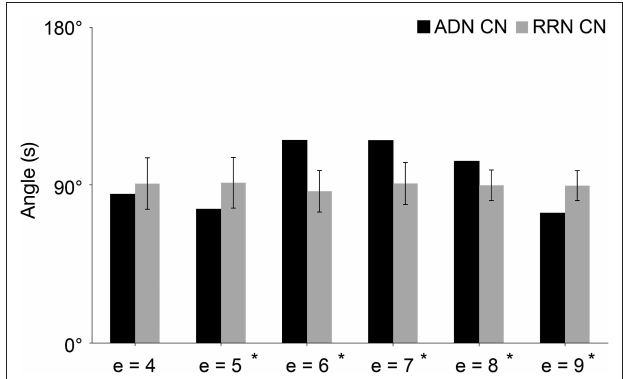
FIGURE 5 | Network similarity analysis of CN, ADN, and RRN. The X -axis represents step e and the Y -axis represents the angle value ( S ). Error bars represent the SD. The results of the network similarity analysis for the input and output set are converted into a matrix and indicate that ADN is lower than RRN when e = 5 and 9, but is higher than RRN when e = 6, 7 and